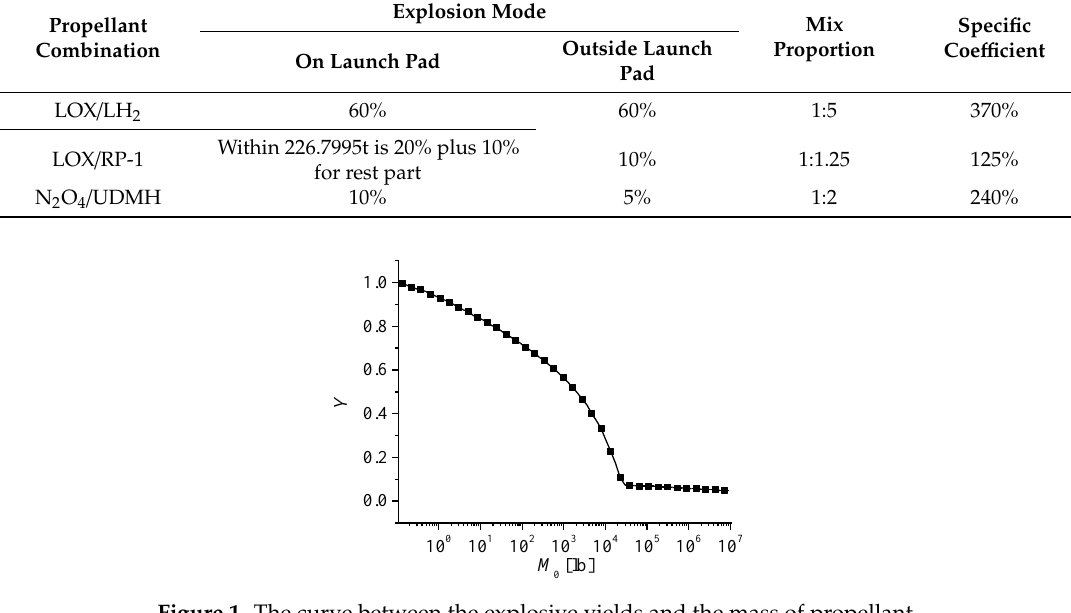
Figure 1. The curve between the explosive yields and the mass of propellant.